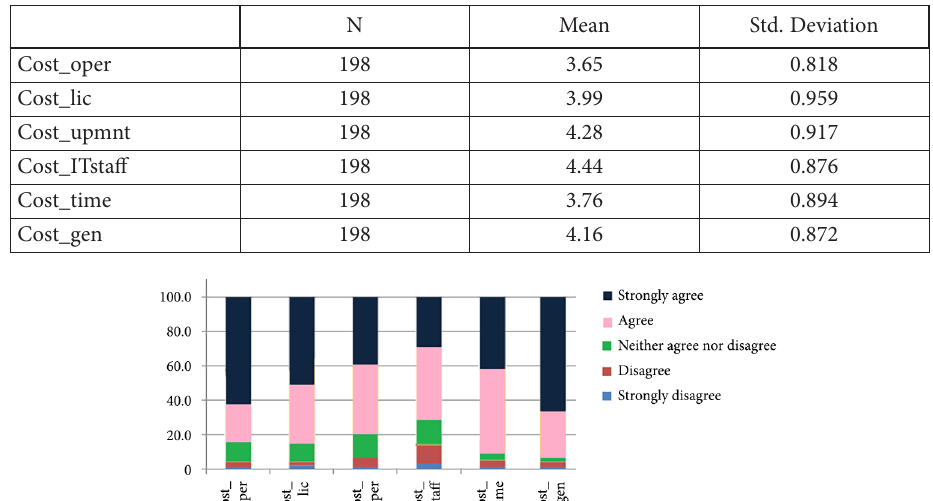
Table 8. Descriptive statistics for the variable managers’ ideas on the costs